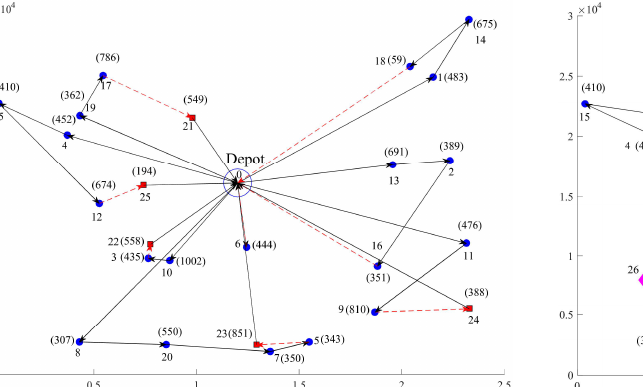
Fig. 1. Vehicle routing problem with backhaul (VRPB)